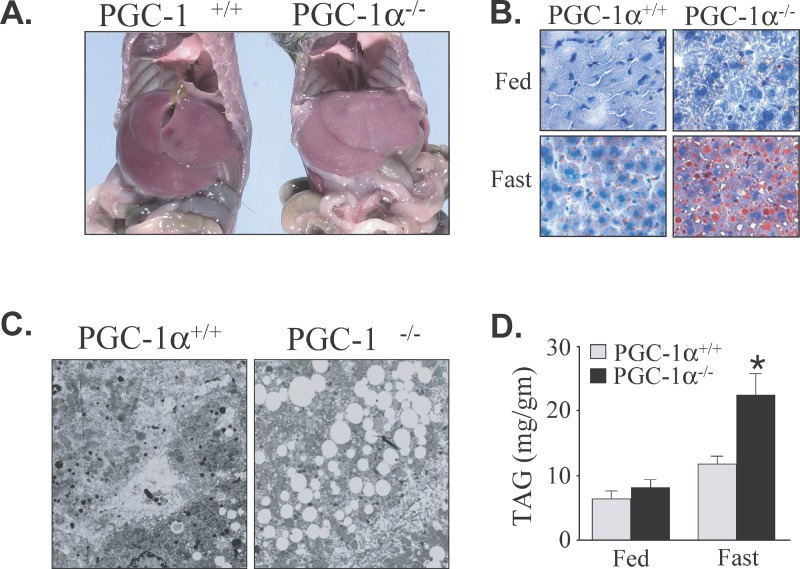
Fasting-Induced Hepatic Steatosis Develops in PGC-1α−/− Mice(A) The photograph depicts the development of a pale liver in PGC-1α−/− mice subjected to a 24-h fast.(B) Oil red O staining of histologic sections of liver taken from PGC-1α−/− mice under fed and 24 h fasted conditions. The red staining indicates neutral lipid.(C) Representative electron micrographs of the liver from PGC-1α+/+ and PGC-1α−/− mice following a 24-h fast. The droplets are indicative of neutral lipid accumulation.(D) Mean liver TAG levels in PGC-1α+/+ (n = 5) and PGC-1α−/− (n = 5) mice under fed and 24-h fasted conditions. * p < 0.05.